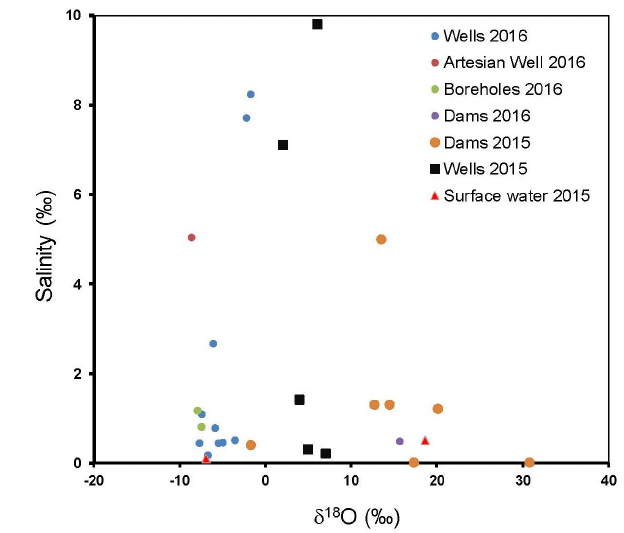
Figure 5. Plot of the stable oxygen isotopes ( δ 18 O) vs. salinity for water samples from the Kuiseb